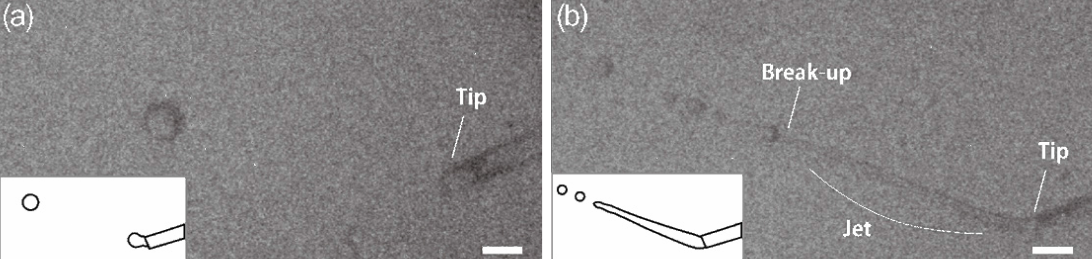
Figure 2. Observed capillary jet in a Centrifuge-Based Droplet Shooting Device (CDSD): ( a ) Dripping regime; ( b ) Jetting regime. The insets depict schematic images of the dripping ( a ), and jetting ( b ), observed. The scale bars are 200 μm.